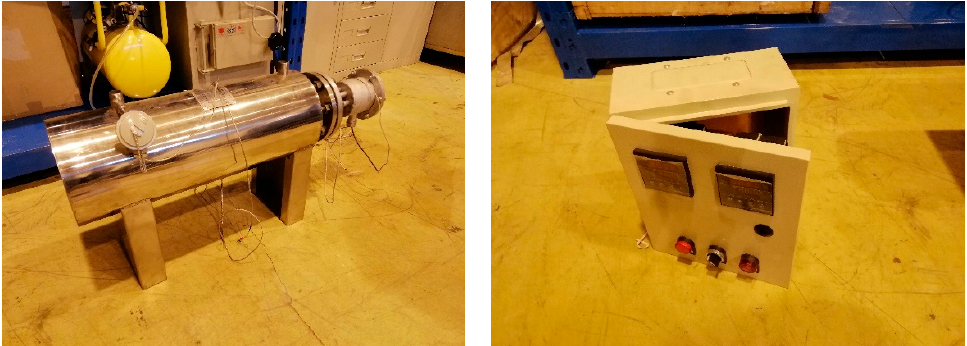
Figure 12. Pipe electric heater and control